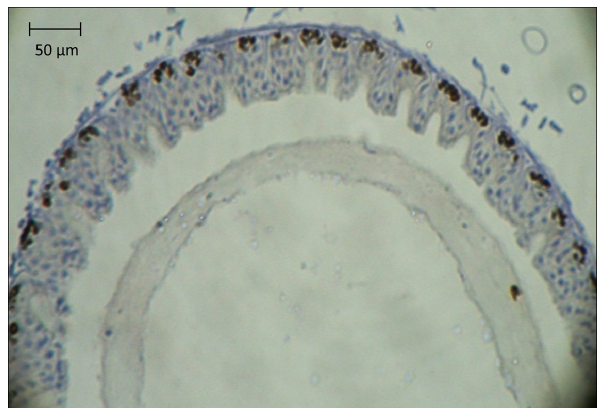
Figure 1. Cross section of the honey bee midgut, showing the midgut epithelium consisting of discrete crypts. The peritrophic membrane is visible in the midgut lumen. In the midgut epithelium, BrdU-labeled nuclei are brown, indicating that DNA replication occurred during the 24 h exposure to the marker. An index of proliferative activity has been developed based on counting the number of labeled nuclei in 10 m m thick cross sections relative to the number of active crypts. This index can be used to rank proliferative activity in different samples and assess possible sublethal effects of ingested xenobiotics on the midgut epithelium. Sections are counterstained with hematox- ylin (in blue) to facilitate detection of crypts and other tissue features.